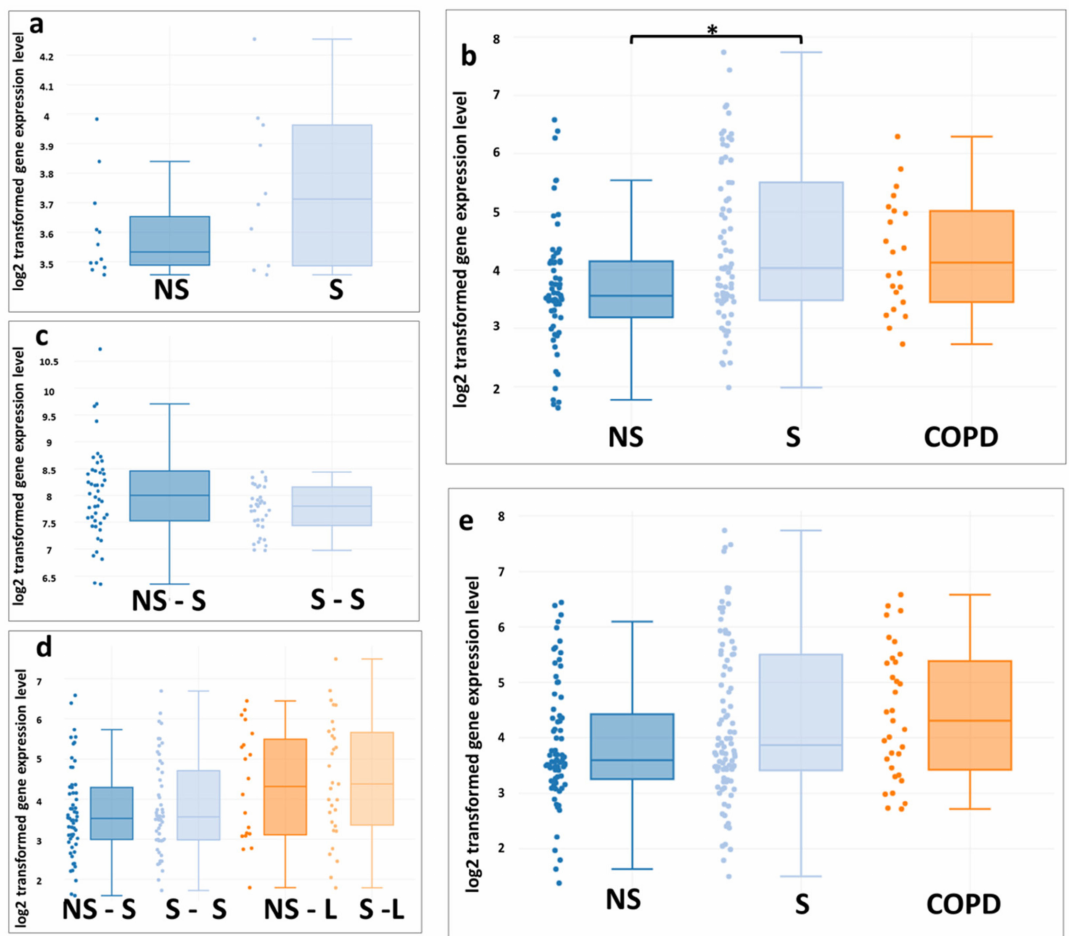
Figure 3. Patterns of ABCA1 expression in the respiratory tract epithelium ( a —GSE4498; b —GSE11784; c —GSE64614; d —GSE76324; e —GSE11906) associated with smoking status: non-smokers (NS) non-smokers–small airways (NS–S); non-smokers–large airways (NS–L); smokers without a diagnosis of COPD (S); smokers–large airways (S–L); smokers–small airways (S–S) and with a diagnosis of COPD (COPD). All datasets were generated from the Affymetrix Human Genome U133 Plus 2 microarray platform (using the Mas 5.0 Normalization method). The data distribution is visualized in the form of box diagrams. Statistically significant differences ( p values and p values adjusted using the algorithm of Benjamini & Hochberg) are shown with asterisks: * p < 0.01, FDR ≤